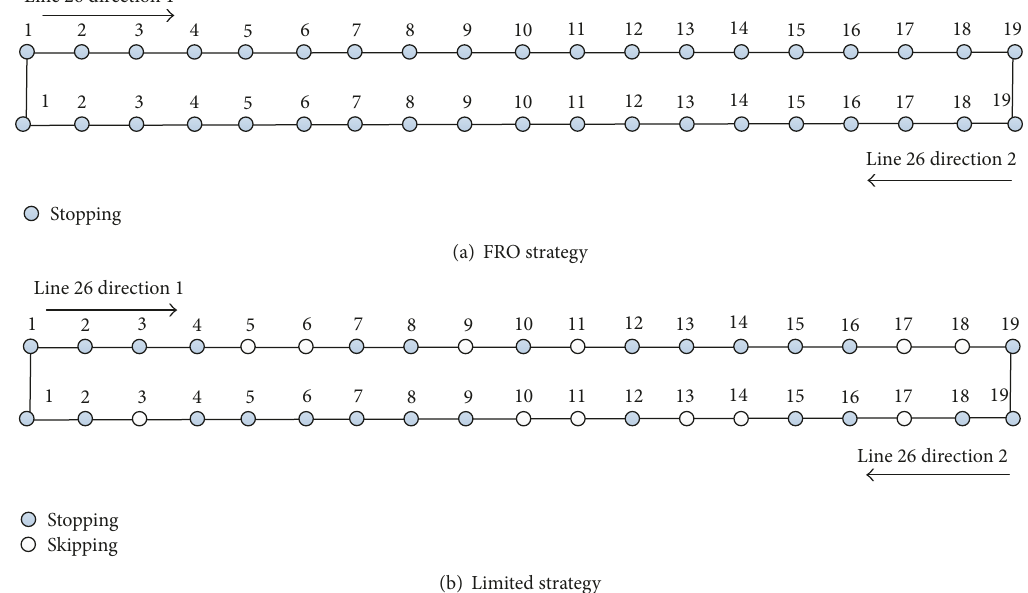
Figure 3: Resulting strategies’ topologies under scenario using optimal strategies.